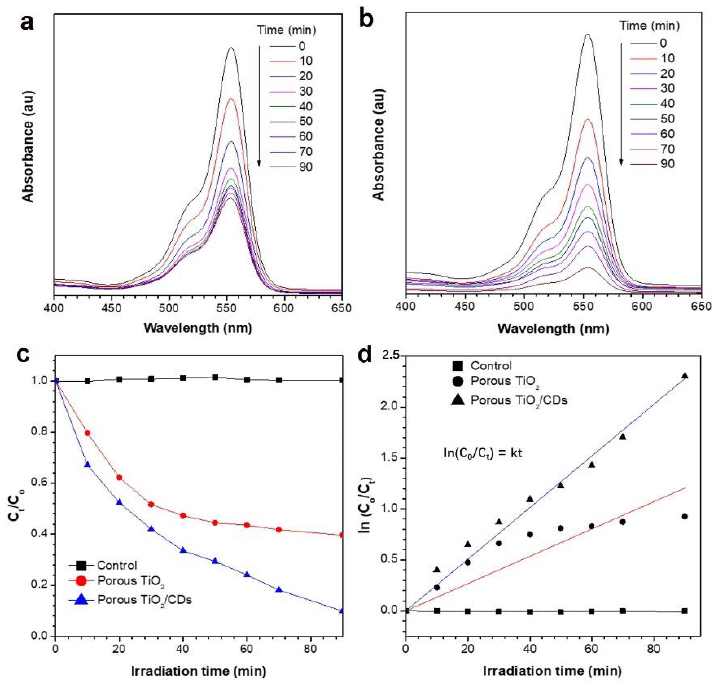
Figure 6. UV-Vis spectra of Rh-B degradation with ( a ) porous TiO 2 and ( b ) porous TiO 2 /CDs under light irradiation for different times. ( c ) Photocatalytic degradation curves of porous TiO 2 and porous TiO 2 /CDs at different time under light irradiation. ( d ) Pseudo-first-order fitted degradation of RhB by porous TiO 2 and porous TiO 2 /CDs.